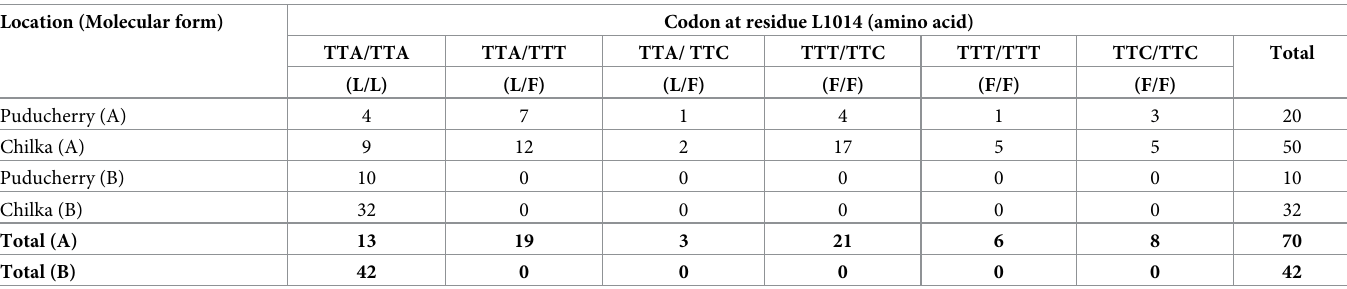
Table 3. L1014-genotyping through DNA sequencing.